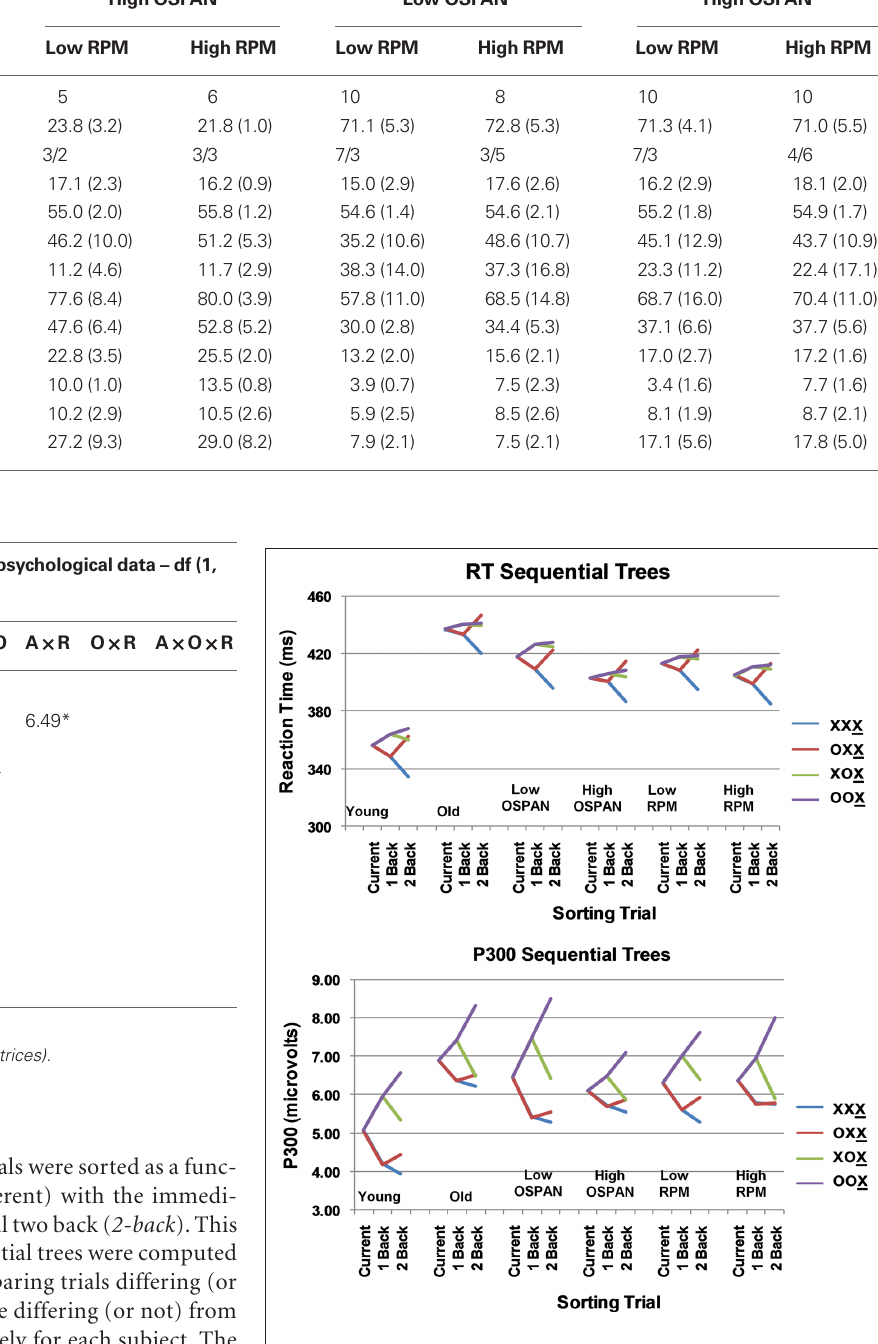
Figure 1 | reaction time (rT; top) and P300 sequential trees (bottom). Trees indicate the RT/P300 amplitude elicited by stimulus X as a function of the preceding two stimuli (1-back, 2-back in the sequential trees) for the various subject groupings. In the RT trees, the ordinate is time in milliseconds; in the P300 trees, the ordinate is the amplitude of the P300 in microvolts. The four different colors represent the four possible sequential conditions (with the underlined X indicating the current stimulus).